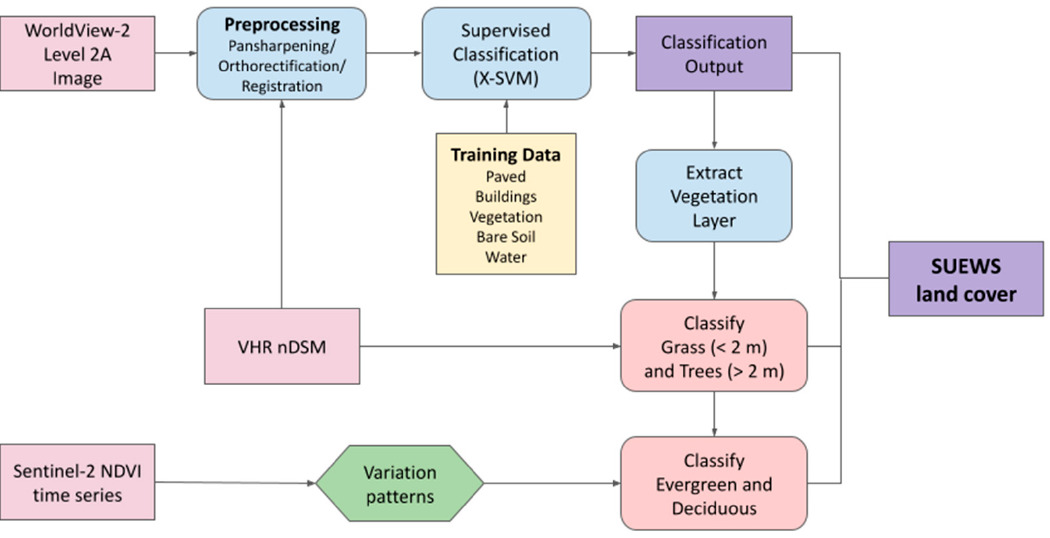
Figure 2. Workflow for the extraction of the land cover scheme required by the model.